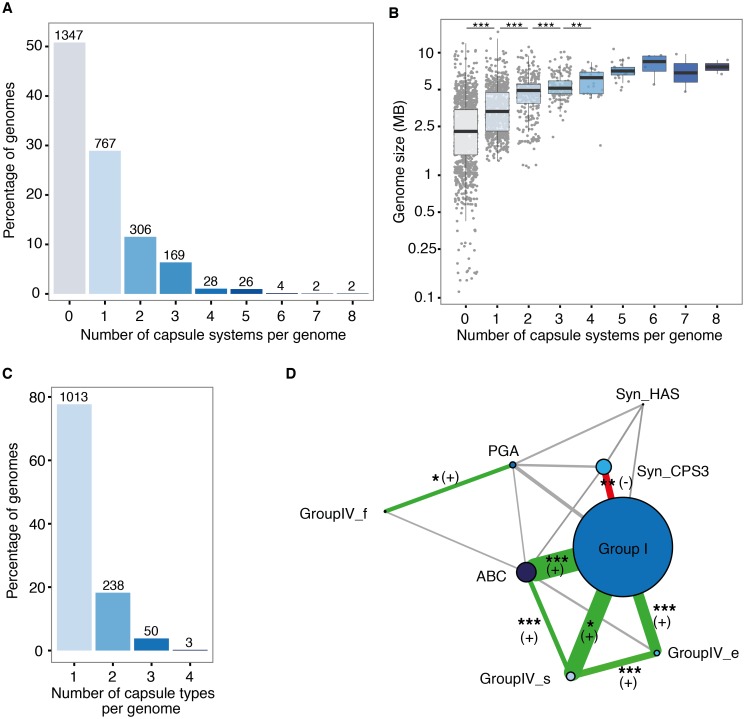
Co-occurrence of capsule systems in genomes.A. Percentage of genomes with none, one or more capsular systems, irrespective of capsule groups. The number of genomes is indicated on top of the bars. B. Box-plots of the distribution of genome size in respect to the number of capsule systems identified in the genome. Y-axis is in log scale. Each point reflects one individual genome. The boxes span from the first to third quartile and the central line indicates the median. The length of the vertical line extends from the first and third quartile to the lowest and highest data points that are no more than 1.5 times away the interquartile range. Genome size was calculated as the sum of all chromosome and plasmid sizes, and was log10-transformed prior to statistical analysis. Asterisks indicate significant differences in median genome size across groups, Tukey post hoc test. *** P < 0.0001, ** P < 0.01. C. Histogram of the number of capsule groups per genome (among genomes encoding at least one capsule). The number of genomes is indicated on top of the bars. D. Network of co-occurrences of capsule groups. The size of the nodes is proportional to the number of genomes encoding the capsule group. The width of the links is proportional to the total number of co-occurrences. Red (-) and green (+) edges indicate significant negative and positive associations, respectively. We indicate three types of significant results. Main results are for the test of significant dependent evolution between capsule groups. These pass two tests: a test of independence on a contingency table (χ2) and a test of phylogenetic dependence accounting for phylogenetic uncertainty (see Methods). *** P < 0.0001, ** P < 0.01, * P < 0.05.